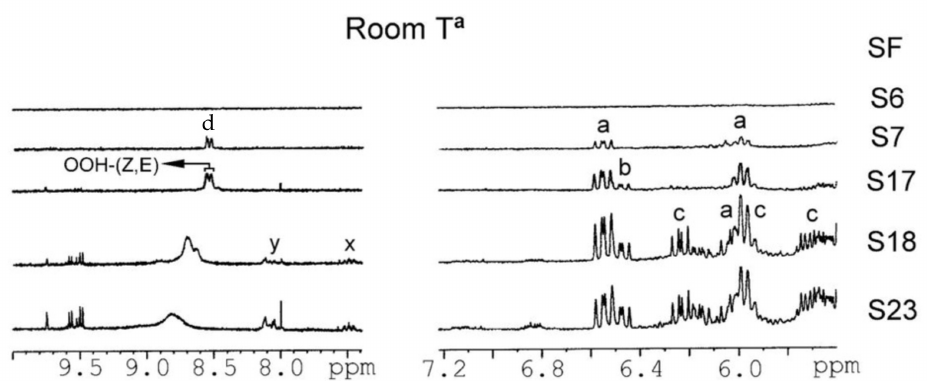
Figure 26. Selected regions of the 1 H-NMR spectra (400 MHz) of sunflower oil (SF) samples stored at room temperature in closed receptacles for different oxidation conditions during storage (Table 4). Letter abbreviations have as follows: ( a ), α -hydroperoxy ( Z , E )-conjugated double bonds; ( b ),